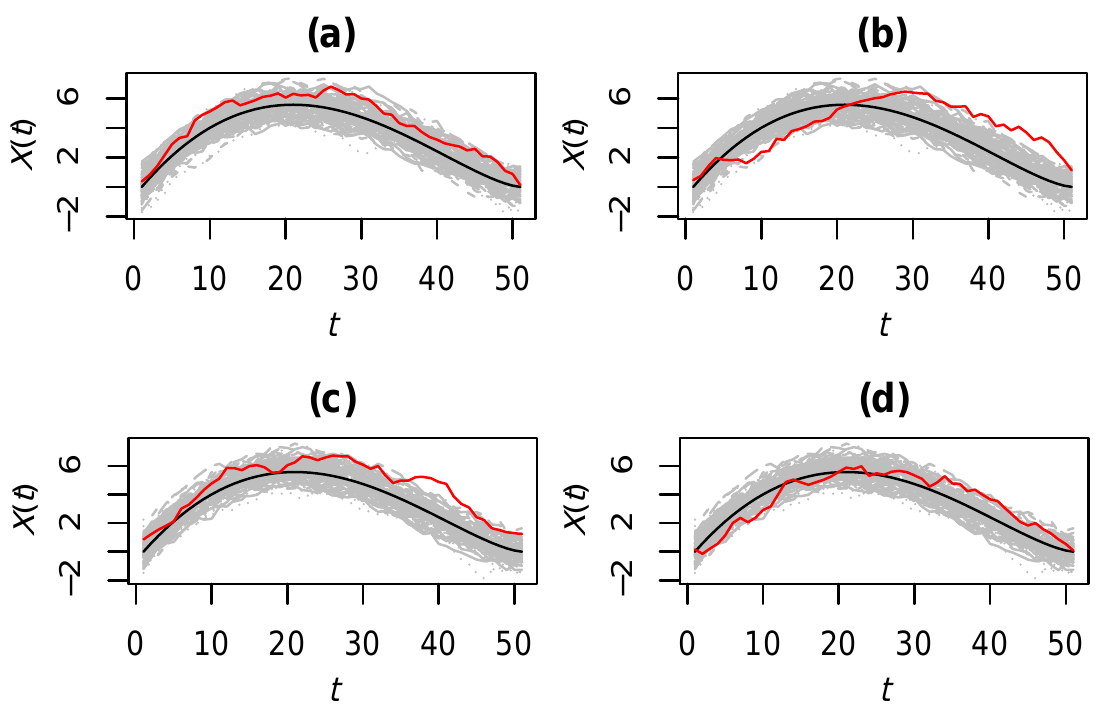
Figure 10. Scenarios in which independence between curves is studied. Changes in the functional mean with respect to its magnitude ( a ) and shape ( b ) are shown. In the case of dependence, panels ( c ) and ( d ) show the simulation scenarios in which changes in the magnitude and shape, respectively, are observed in the functional